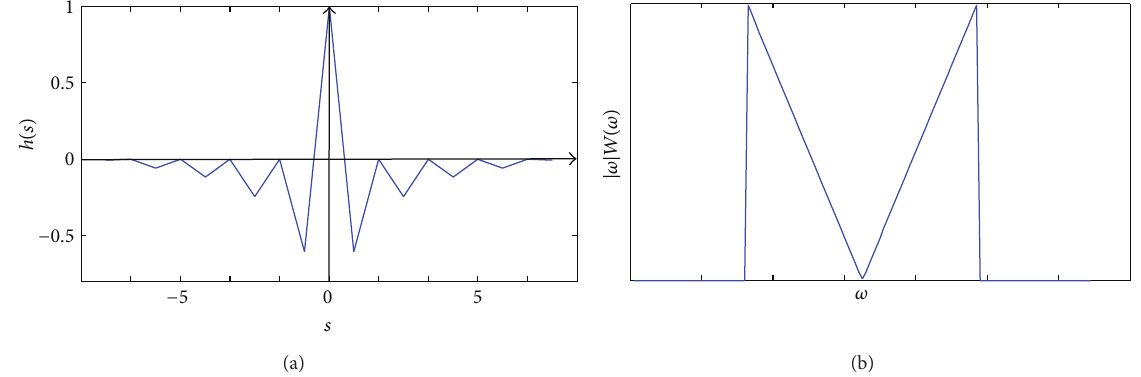
Figure 1: The truncated ramp filter by Hamming window. (a) Space domain. (b) Frequency